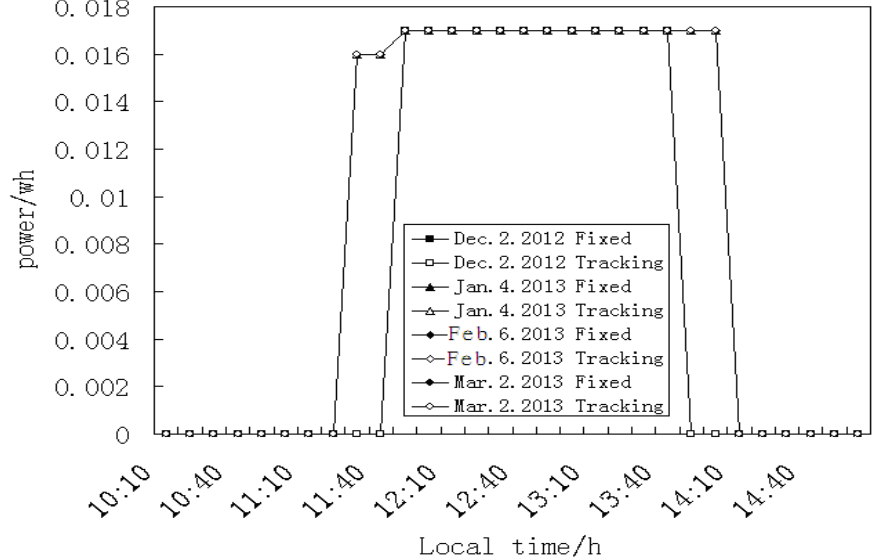
Figure 3. Power generated (Wh) over time (plotted in 10-min increments) on cloudy days.